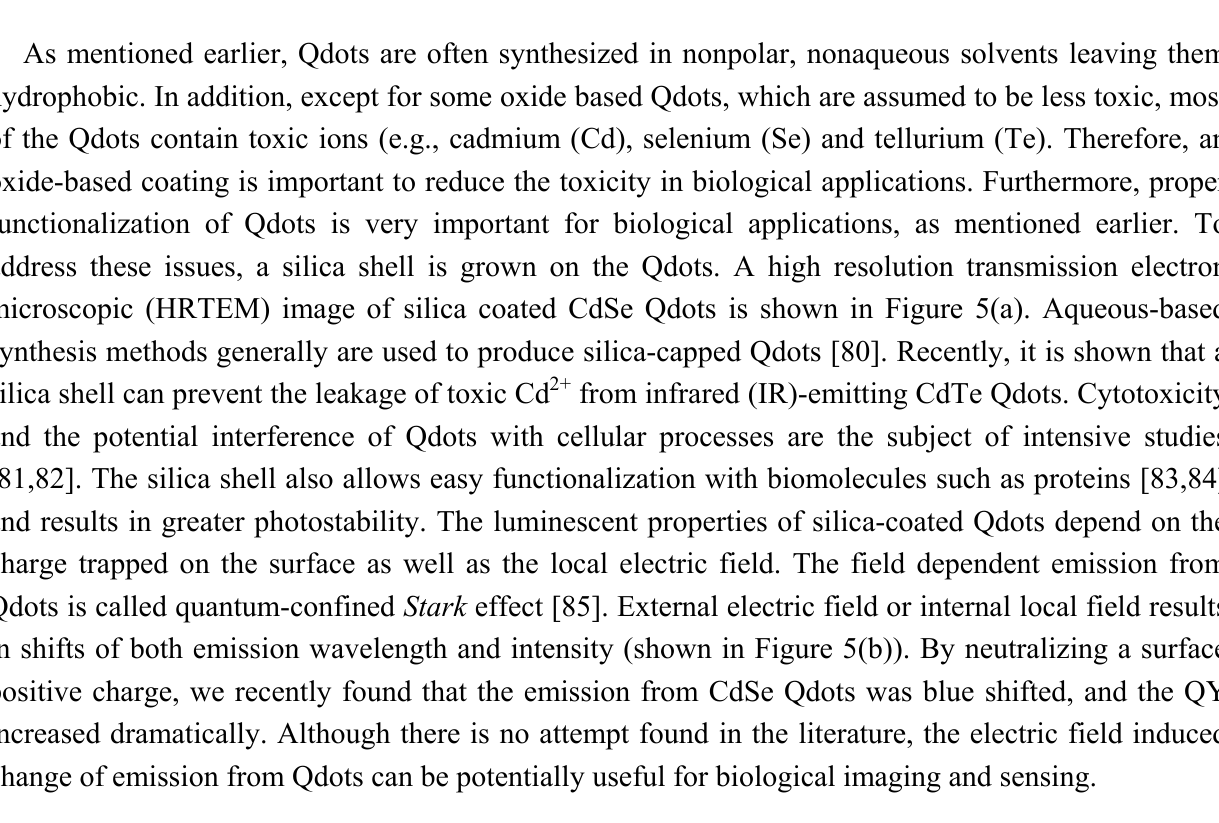
Figure 5. (a) High resolution transmission electron micrograph of silica-coated CdSe Qdots; (b) Photoluminescence (PL) spectra from CdSe (solid) and silica coated CdSe (dotted) Qdots with variation of core size; inset photograph shows emitting color under long wavelength UV-light